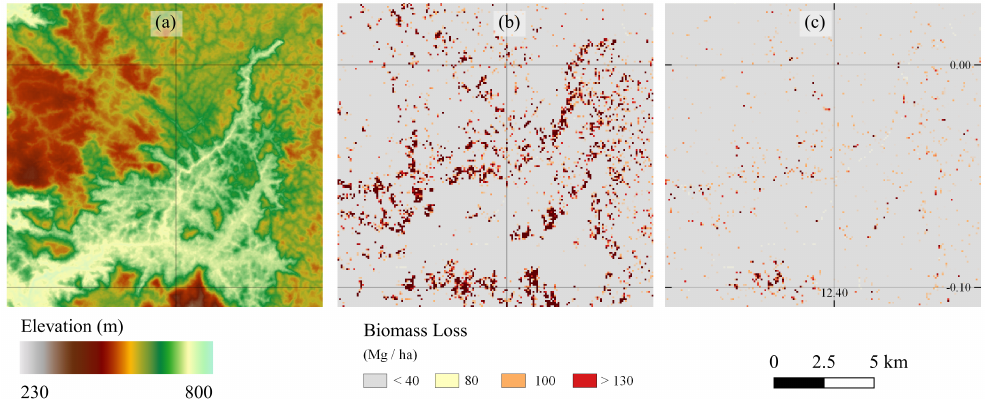
Figure 11. Example of topographic artifacts in TDX predicted degradation. ( a ) SRTM elevation; ( b ) potential degradation using naive averaging method; ( c ) potential degradation using pass selec- tion